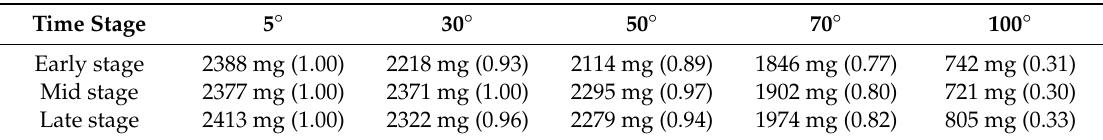
Table 2. Time integrals blood plasma infiltration and ratio of the time integral to the value when the CAIS was 5°.